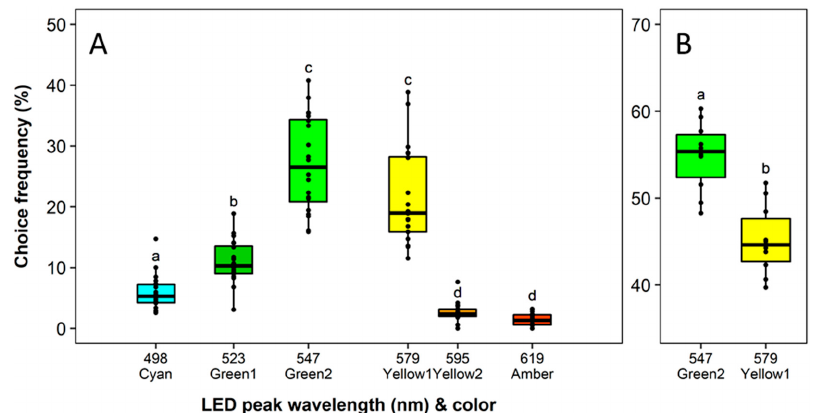
Figure 5. Wavelength preferences of Frankliniella occidentalis in multiple-choice experiment with light-emitting diodes (LEDs) in the spectral range from Cyan to Amber ( A ) and in dual-choice experiments with the two most attractive green and yellow LEDs ( B ). See Table 1 and Figure 2 for LED specifications. Significant di ff erences are indicated by di ff erent letters (generalized linear model, Tukey test, p < 0.05, n = 20).